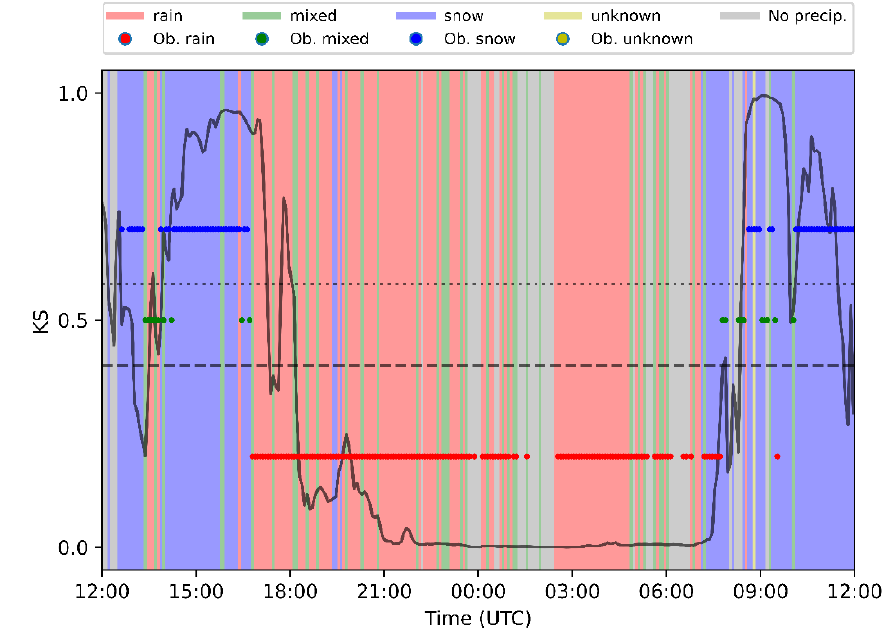
Figure 10. Precipitation type estimated from different sources for the 24 to 25 March 2017 event showing precipitation type estimates from Method2 (vertical, colored stripes), disdrometer observations (small colored circles), and AWS derived Koistinen-Saltikoff (KS) probability of snow (thick black line) at AWS S0 with reference lines for values separating the rain and mixed classes (dashed black line) and the mixed and snow classes (black dotted line). For the sake of simplicity disdrometer colored circles are shown at fixed KS probabilities within the corresponding class.